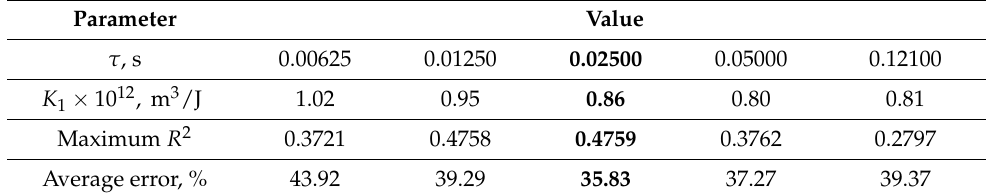
Table 3. Pre-polished V-shape artifact: calculating the optimal τ and K 1 values (maximum R 2 ).